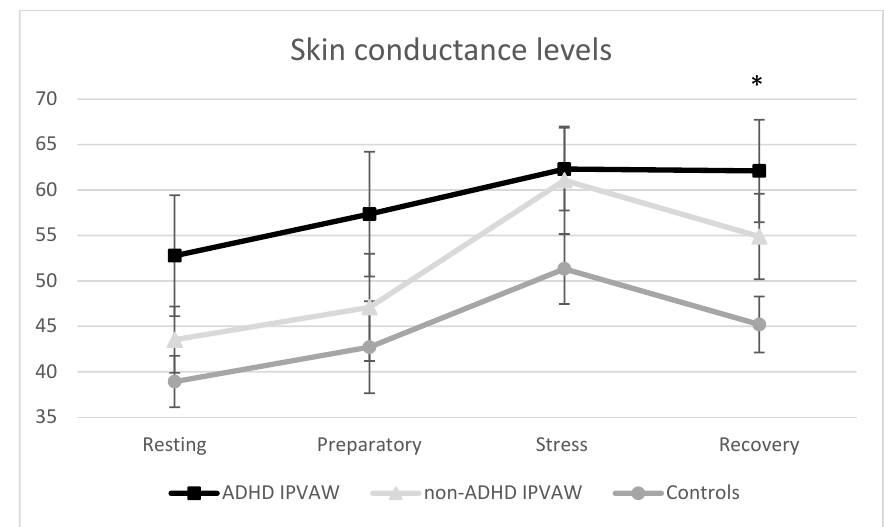
Figure 1. Skin conductance level changes in response to acute laboratory stress for all groups. ADHD: Attention Deficit Hyperactivity Disorder; IPVAW: Intimate Partner Violence Against Women; * p < 0.05.